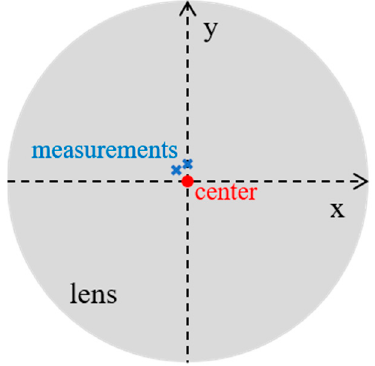
Figure 3. Locations of the two measured regions on the biplane ophthalmic lens.